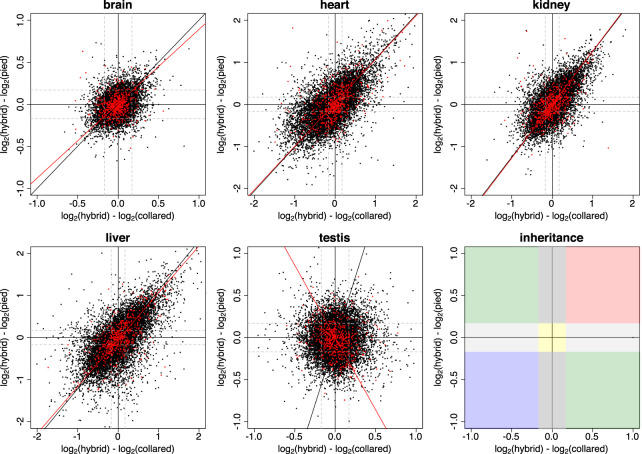
Inheritance mode of gene expression patterns in natural F1 hybrids of collared flycatcher and pied flycatcher in five tissues. The scatterplots show shrunken log2-fold changes between F1 hybrids and collared flycatcher on the x-axis, and between F1 hybrids and pied flycatcher on the y-axis. One dot represents the inheritance pattern of one gene. Autosomal genes are shown in black, genes located on the Z Chromosome are shown in red. The black and the red type II regression lines represent the major variation in log2-fold changes for autosomal and Z-linked genes, respectively. Vertical and horizontal black solid lines indicate the coordinate axes. Gray dashed lines indicate the fold-change threshold of 1.125, used for classification of inheritance patterns. Right, bottom panel: The color code illustrates the thresholds used for classification of genes, with conserved in yellow, pied-dominant inheritance in light gray, collared-dominant inheritance in dark gray, additive inheritance in green, overdominant inheritance in red, and underdominant inheritance in blue.